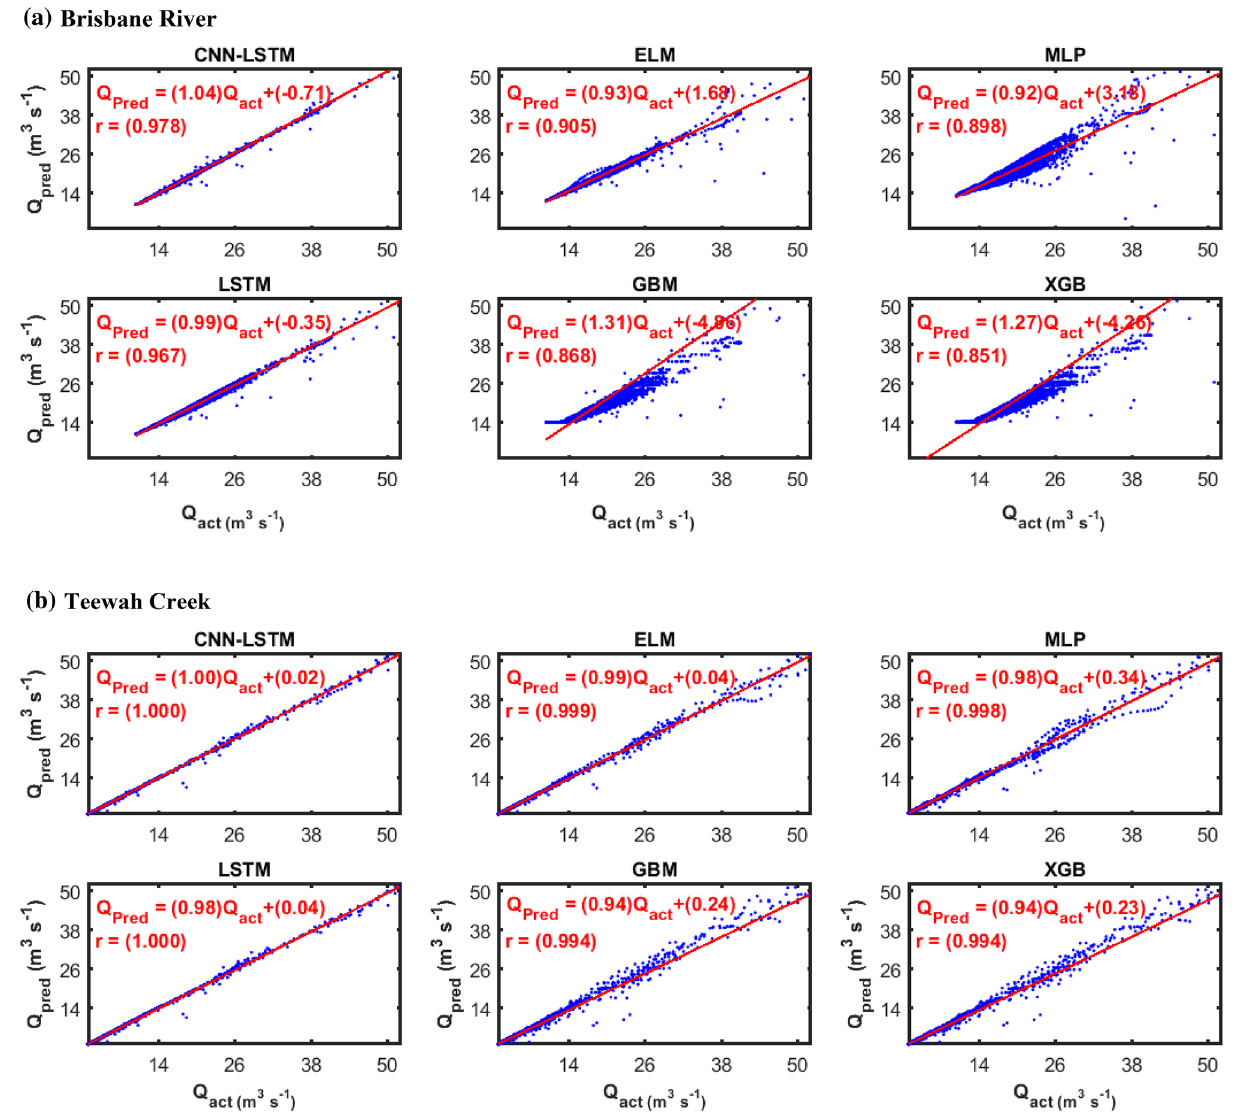
Figure 11. Scatterplot of predicted ( Q pred ) and actual ( Q act ) hourly streamflow ( Q , m 3 s −1 ) for ( a ) Brisbane River and ( b ) Teewah Creek using the CNN-LSTM, Extreme Learning Machine (ELM), Multi-Layer Perceptron (MLP), Long Short Term Memory Network (LSTM), Gradient Boosting Regression (GBM) and Extreme Gradient Boosting Regression Model (XGB) model. Least square regression equations of the form y = mx + C and the correlation coefficient (r) is inserted in each